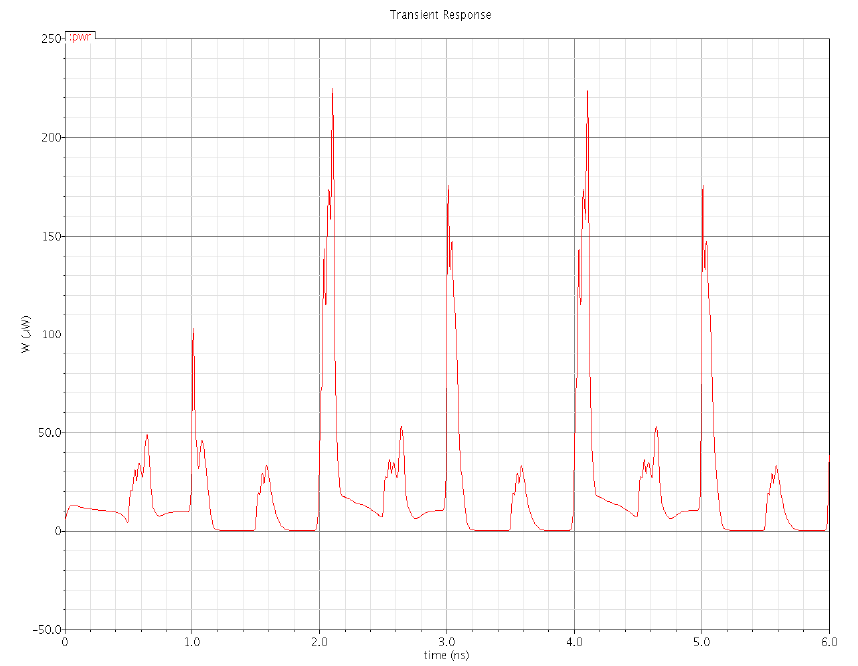
Figure 17. Total power dissipation in the hybrid-latch flip-flop (HLFF).